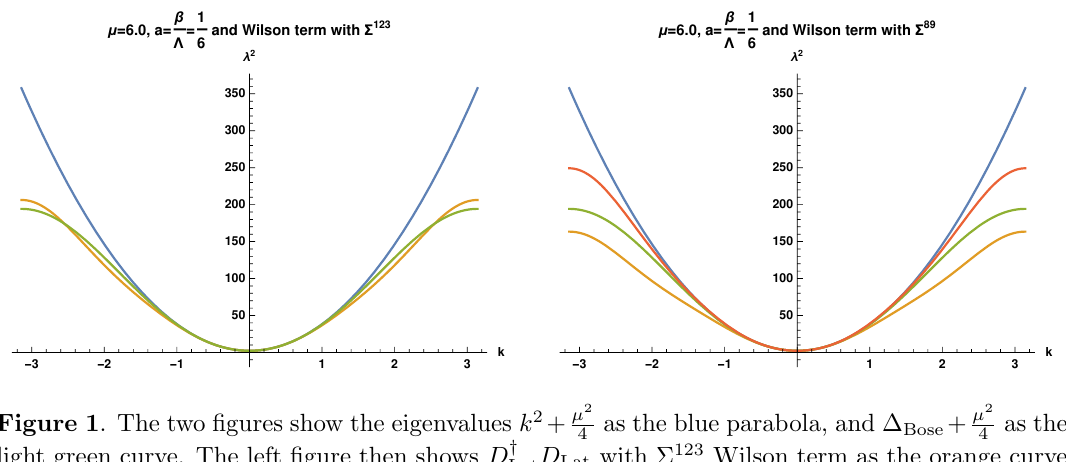
Figure 1 . The two (cid:12)gures show the eigenvalues k 2 + (cid:22) 2 light green curve. The left (cid:12)gure then shows D y while the right (cid:12)gure shows the two distinct eigenvalues of D y as the red and orange curves. All plots are with (cid:22) = 6 : 0, a = 1 r 2 f = 0 : 1488, the parameter values used in the simulations and a representative lattice spacing.